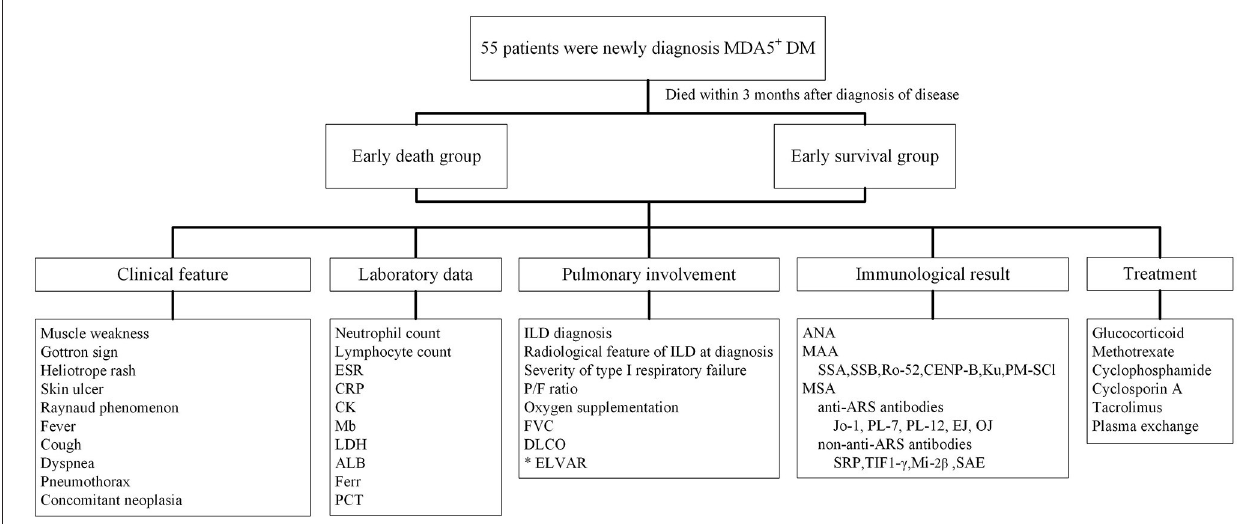
FIGURE 1 | Flow chart of clinical research design for newly diagnosed MDA5 + DM patients. ALB, albumin; ANA, antinuclear antibody; ARS, minoacyl-tRNA synthetase; CRP, C reactive protein; CK, creatinine kinase; DLCO, carbon monoxide diffusing capacity; ELVAR, effective lung ventilation area ratio; ESR, erythrocyte sedimentation rate; Ferr, ferritin; FVC, forced vital capacity; ILD, interstitial lung disease; LDH, lactate dehydrogenase; MAA, myositis associated antibody; Mb, Myoglobin; MDA5, melanoma melanoma differentiation associated gene 5; MSA, myositis specific antibody; PCT, procalcitonin; P/F ratio, PaO2/FiO2 ratio; SRP, signal recognition particle; SAE, anti-small ubiquitin-like modifier antibody; TIF1- γ , transcription intermediary factor